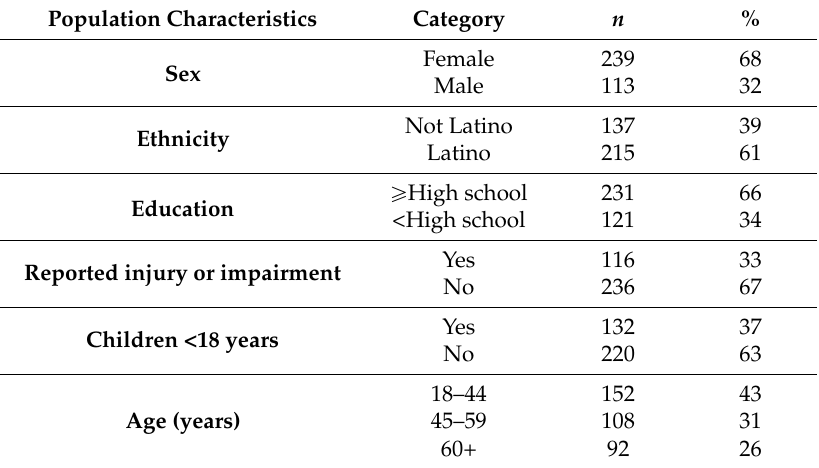
Table 1. Study population